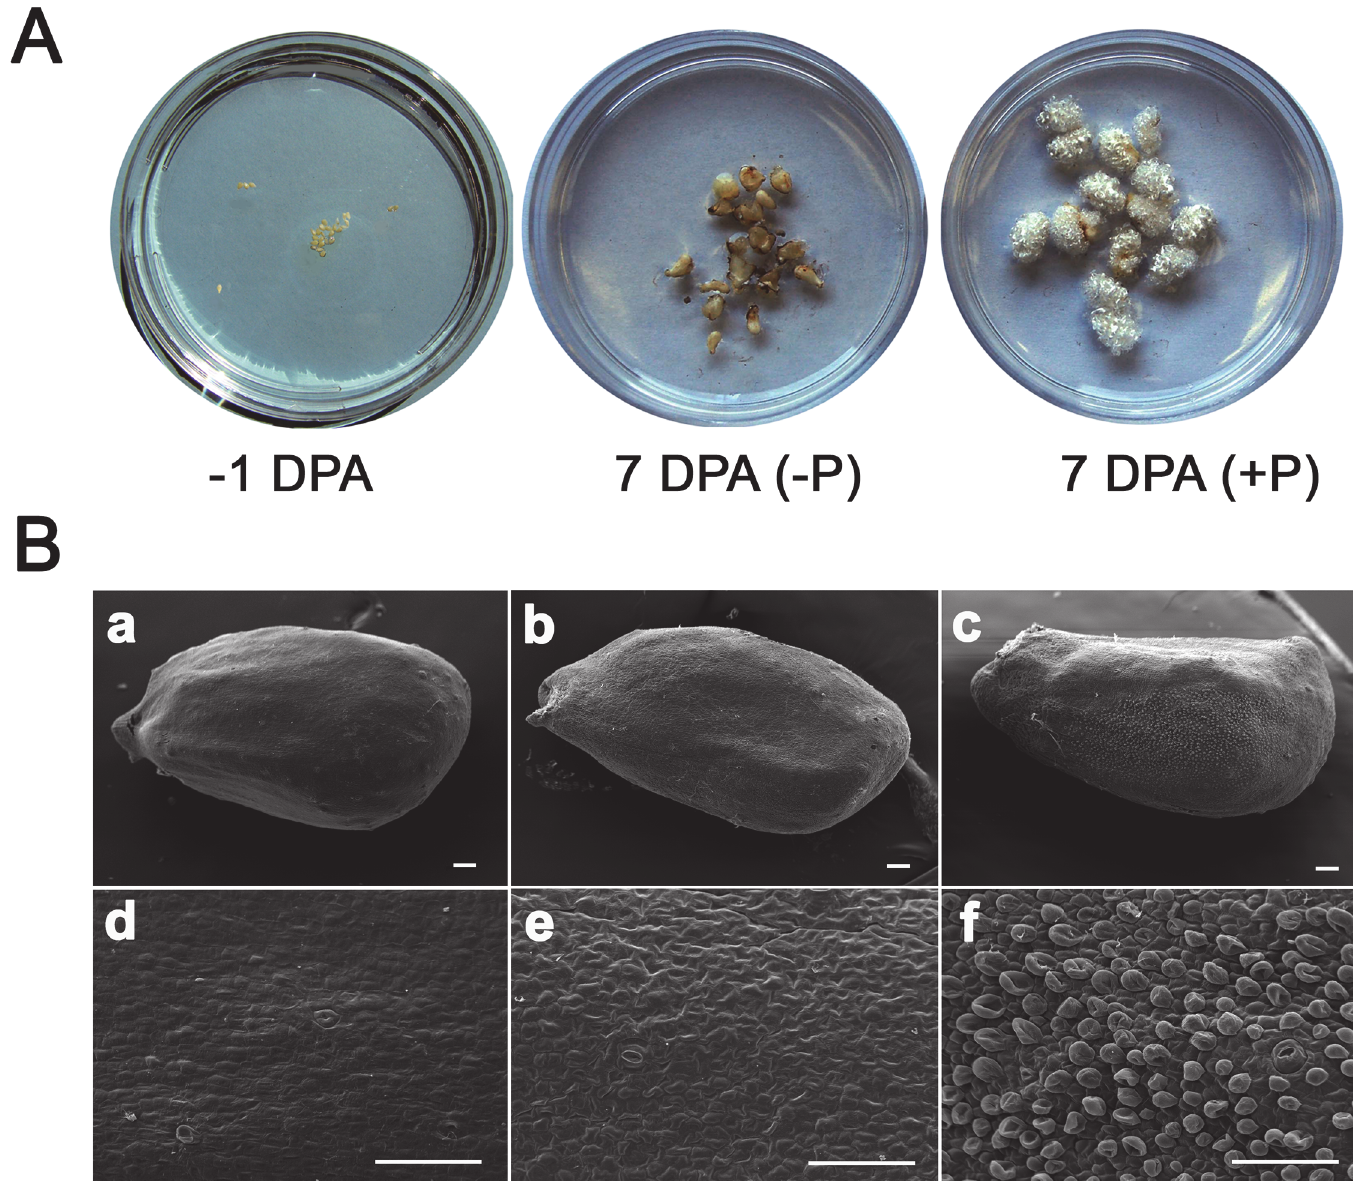
Fig 2. Fiber initiation of G . hirsutum grown in vitro . A. Phytohormonal effects on fiber development in cultured ovules. One day before anthesis (-1 DPA) ovules ( G . hirsutum , TM-1) containing no fiber initials were treated with exogenous phytohormones (+P) consisting of 5 μ M IAA and 1 μ M GA until 7 DPA. No phytohormone (-P) was used as a negative control. B. Differentiation of fiber initials cultured with exogenous phytohormones. Scanning microscopic images of G . hirsutum TM-1 unfertilized ovules (top panel) and epidermal tissue (bottom panel) were photographed before (a & d) and after culture for 24 h on basal medium either in the absence (b & e) or presence (c & f) of phytohormones (5 μ M IAA and 1 μ M GA). The bars represent lengths of 50 μ